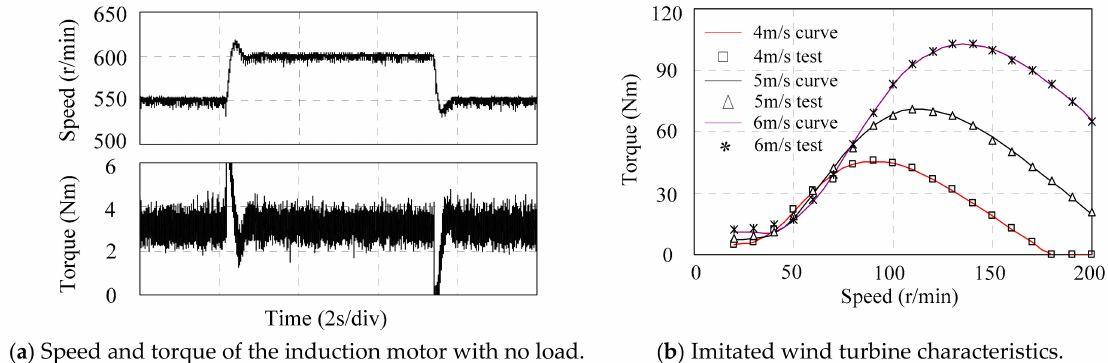
Figure 10. Experimental results of the imitated wind turbine.